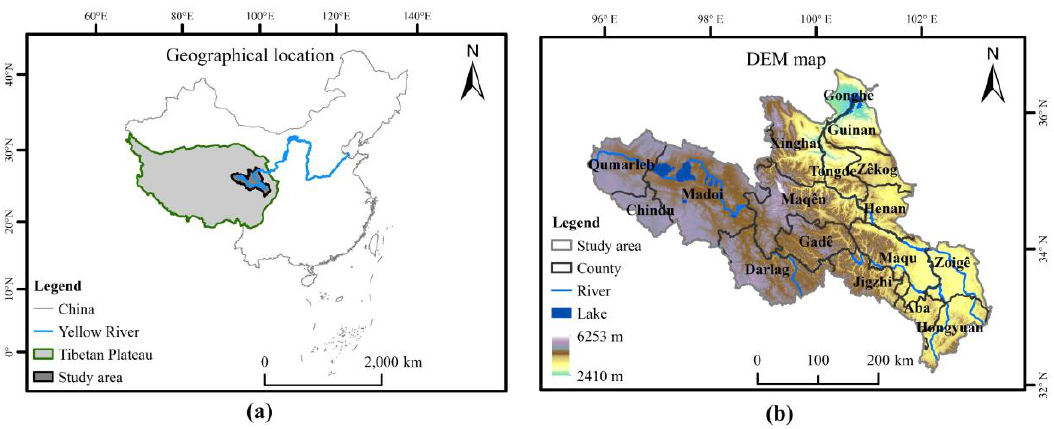
Figure 1. The source region of the Yellow River (SRYR): ( a ) geolocation location; ( b ) digital elevation model (DEM) map.